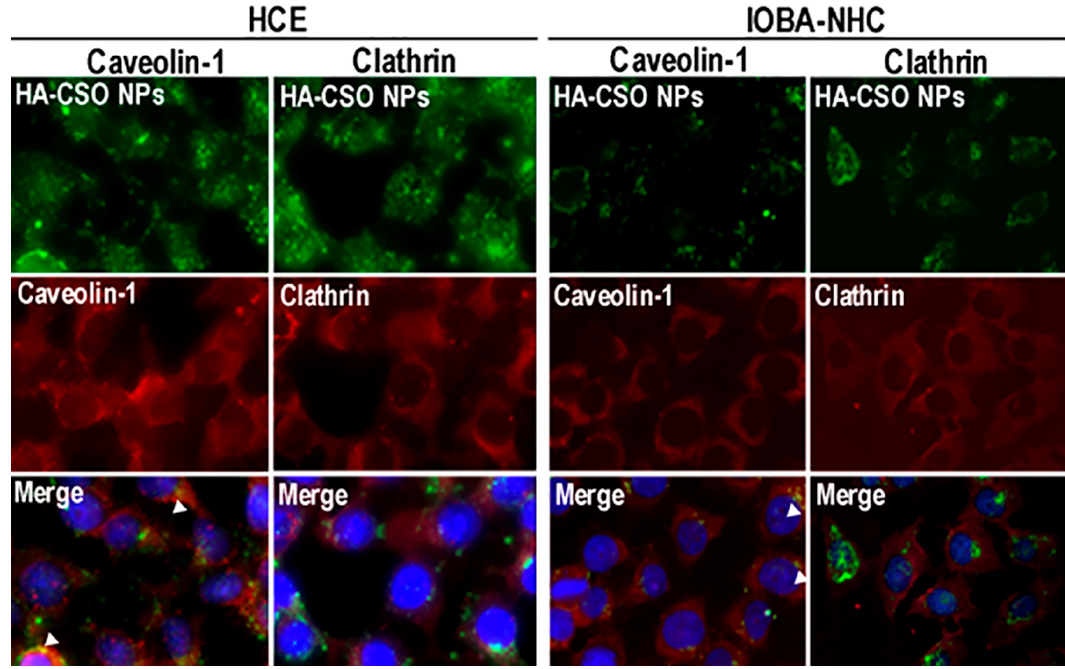
Figure 8. Caveolin-1 and clathrin immunofluorescence in HCE and IOBA-NHC cells